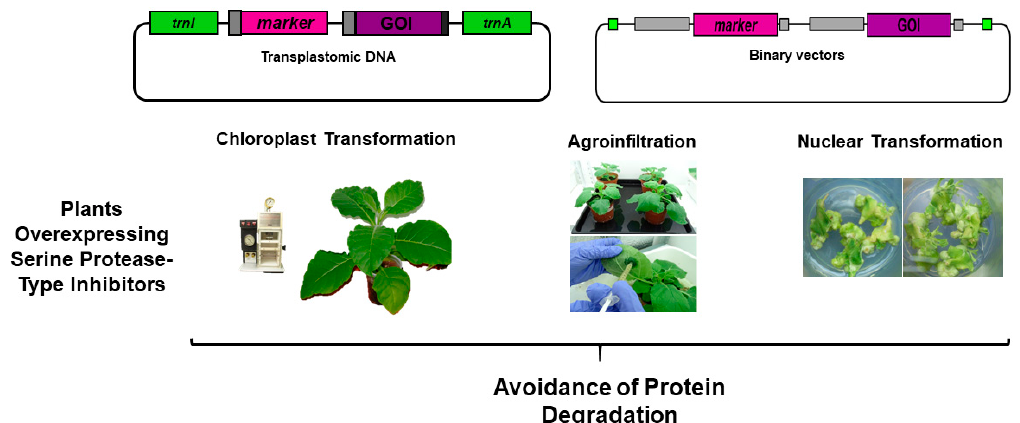
Figure 3. Co-expression of serine protease inhibitors could help to minimize the proteolytic activity and to avoid the recombinant protein degradation in transplastomic, transgenic plants or in plants that transiently express recombinant proteins. The protease inhibitor can be targeted in the same organelle (chloroplast transformation) where the recombinant protein would be expressed or co-expressed. Transgenic plants over-expressing protease inhibitors would be more suitable to express recombinant proteins by agroinfiltration.